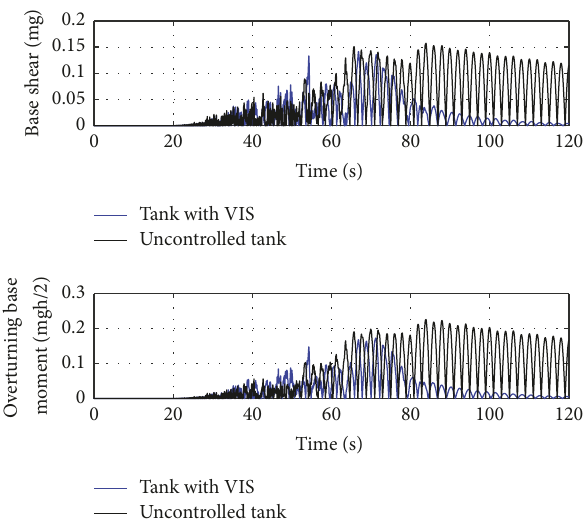
Figure 14: Base shears and overturning base moments of the tank with the VIS and the uncontrolled tank under the excitation of the Coalinga earthquake.